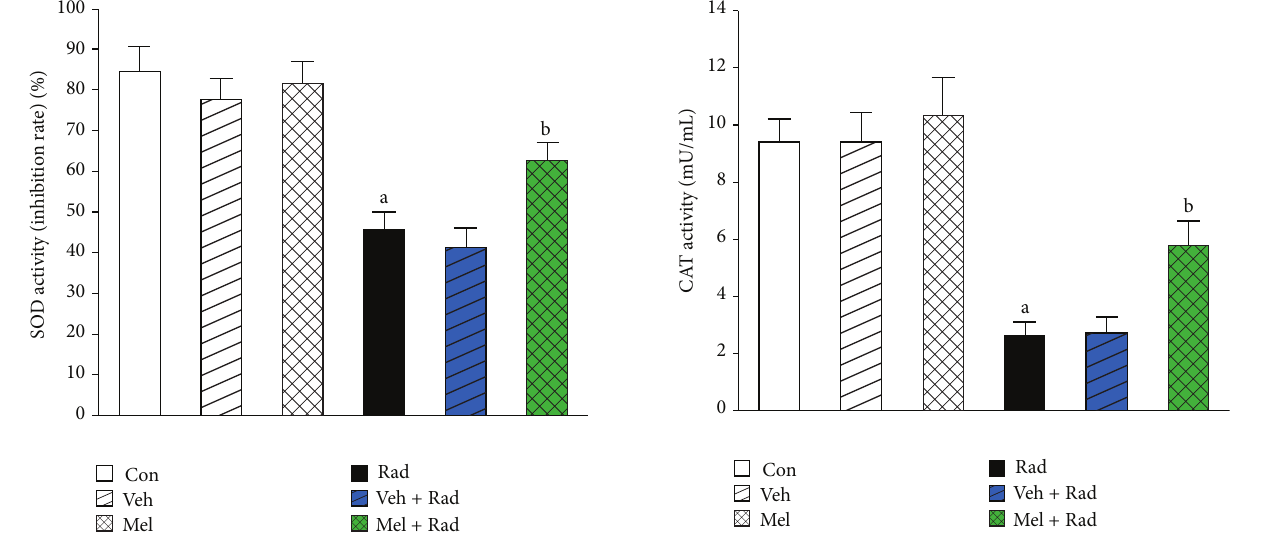
Figure 5: The effect of melatonin on SOD activity in rats subjected to whole body gamma irradiation. Data represent mean ± standard error on the mean (SEM) for 5 animals per group. Con: Control group, Veh: Vehicle only group, Mel: Melatonin only group, Rad: Radiation only group, Veh + Rad: Treated with vehicle and exposed to10Gyradiation,andMel+Rad:Treatedwith100 mg/kgmelatonin before exposure to 10Gy radiation. a 𝑃 < 0.001 when compared to Control group. b 𝑃 < 0.001 when compared to the radiation only group.